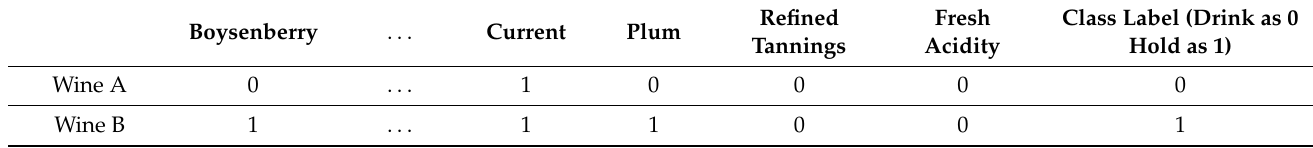
Table 2. A sample wine dataset with the Drink and Hold attributes used as a class label. Compared with the data extracted from the Computational Wine Wheel, shown in Figure 2, additional column has been added to the end of the data, holding the class label. The “ . . . ” in the third column indicates much more attributes are included in the data format. Boysenberry . . . Current Plum